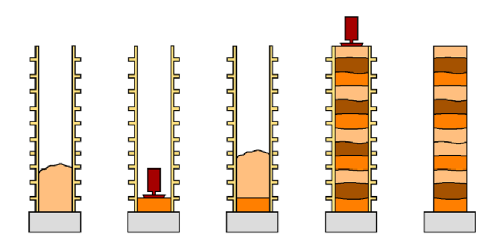
Figure 4. The process of building a rammed earth